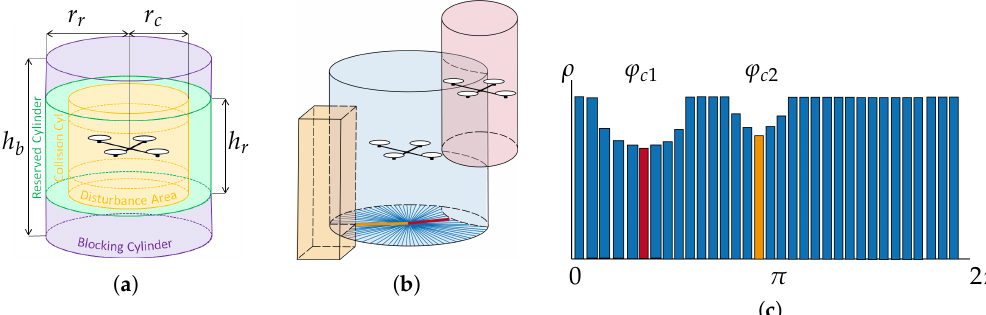
Figure 2. ( a ) Representation of the three concentric cylinders that define the collisions and conflicts. ( b ) A UAV (in the middle) computes its COD with two obstacles: an external, static obstacle and another UAV. The reserved cylinder of the central UAV is shown to see how it is invaded by the collision cylinder of the other UAV and the static obstacle. ( c ) Equivalent polar representation of its COD with the two conflict